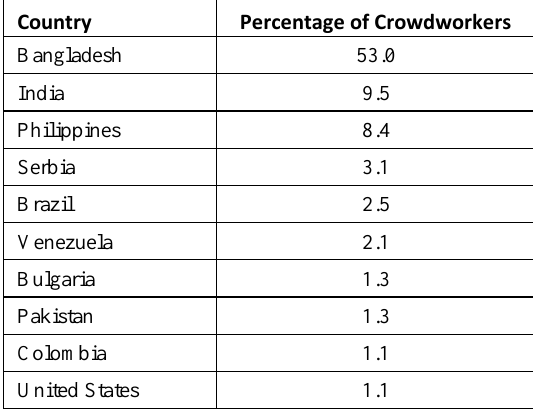
Table 1 . Distribution of origins of the crowdworkers sorted by top 10 countries.